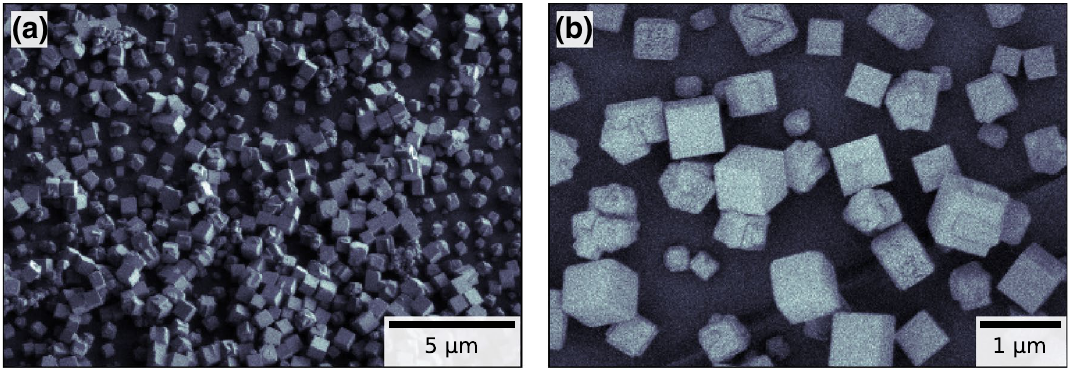
Figure 2. Scanning electron microscopy (SEM) overview images of two different regions on the same side of a polyimide foil covered with copper(I) oxide nanocubes similar to the ones used in the X-ray imaging experiment. ( a ) Secondary electron image of the tilted sample taken at 1keV accelerating voltage showing mostly smooth nanocubes and varying local covering densities of the surface with nanocubes; ( b ) Mixed secondary and back scattered electron beam image taken at 0.3keV accelerating voltage reveals irregularly facets at the surface of some nanocubes and additionally irregular shaped particles. The images were recorded using a Hitachi Regulus 8200 Series FE-SEM , operation on the control software version 3.2. The figure was created using matplotlib 35 (version 3.1.3 36